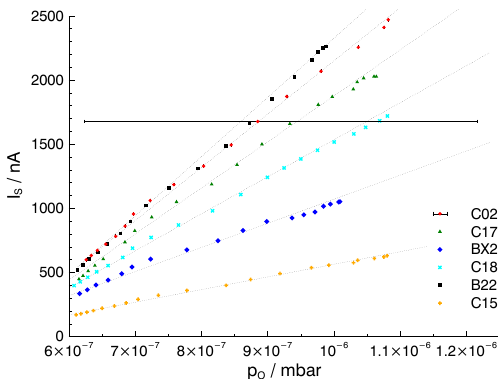
Figure 6. Calibration curves for the atomic oxygen sensors la- beled C02–C15 flown on WADIS-1. Sensor currents are plotted over atomic oxygen partial pressure. The error bar represents the uncertainty due to the pressure measurement and shifted electron energy in the QMS